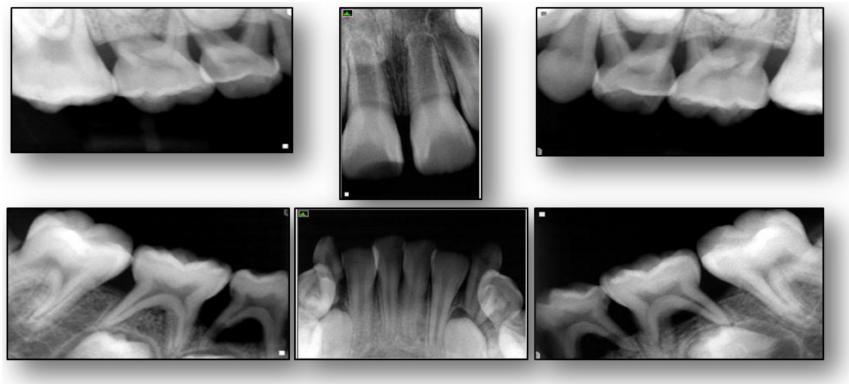
Figure 1. Clinical oral presentation of an eight-year-old male patient with a history of GSD type Ib. Extensive oral inflammation of the supporting periodontal tissues.